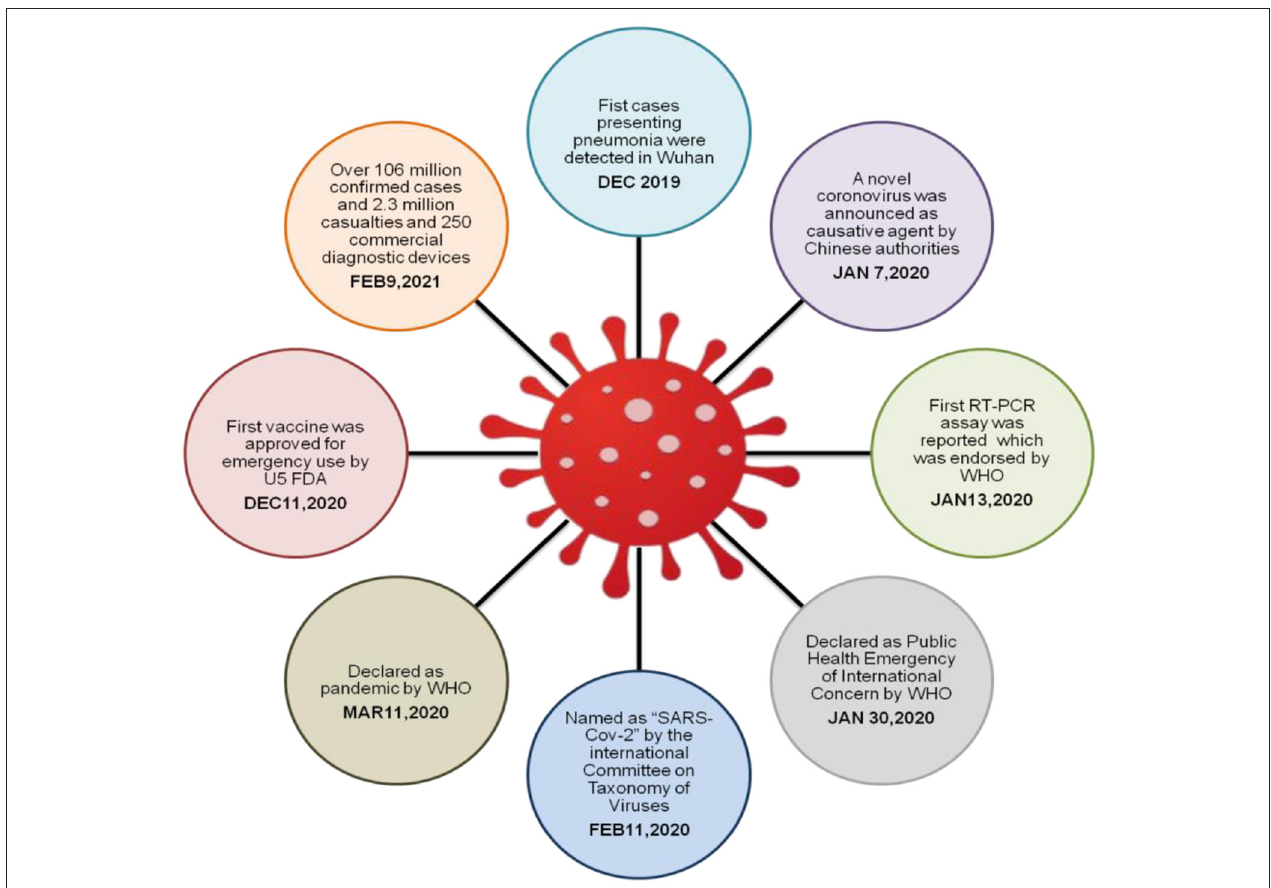
FIGURE 1 | Timeline of